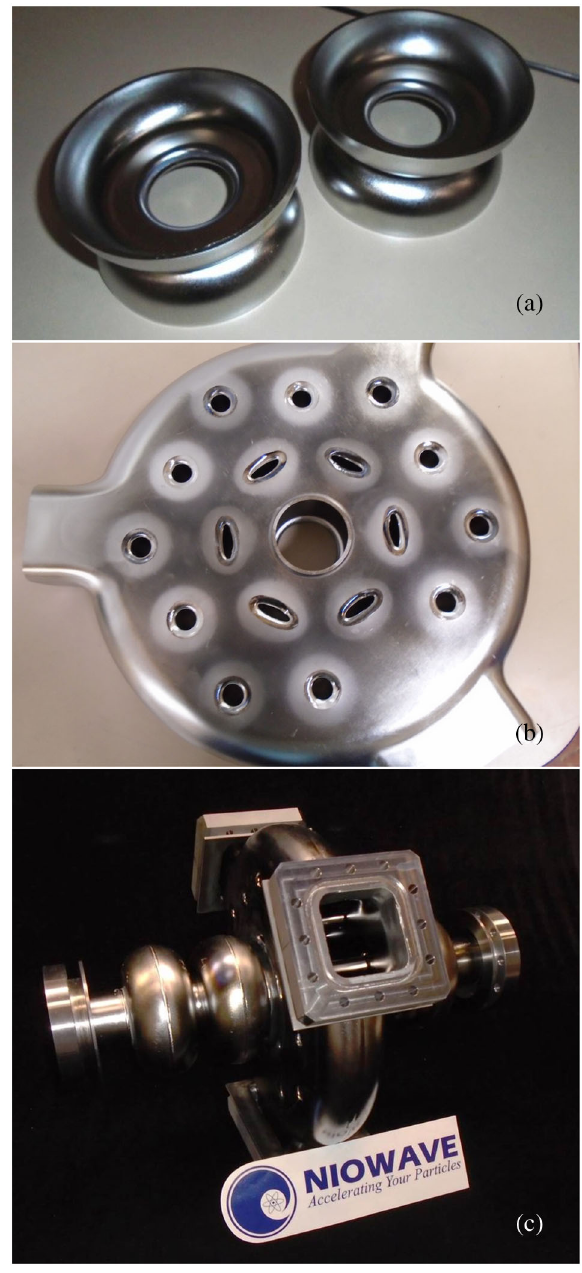
FIG. 8. Halves of the elliptical cells after being welded together at the irises (a). Photo of the PBG cell with welded rods (b). Final photo of the fabricated five-cell cavity